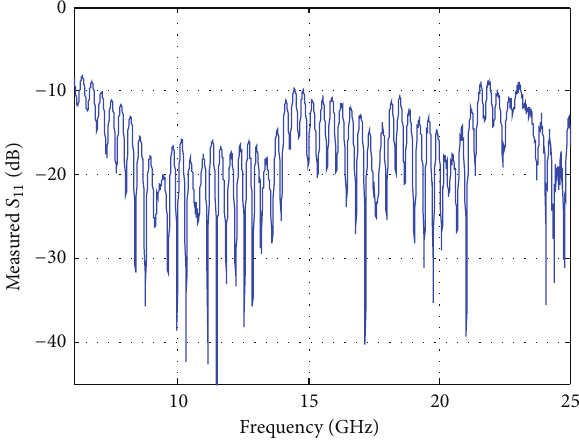
Figure 4: Measured return loss of the LTSA.